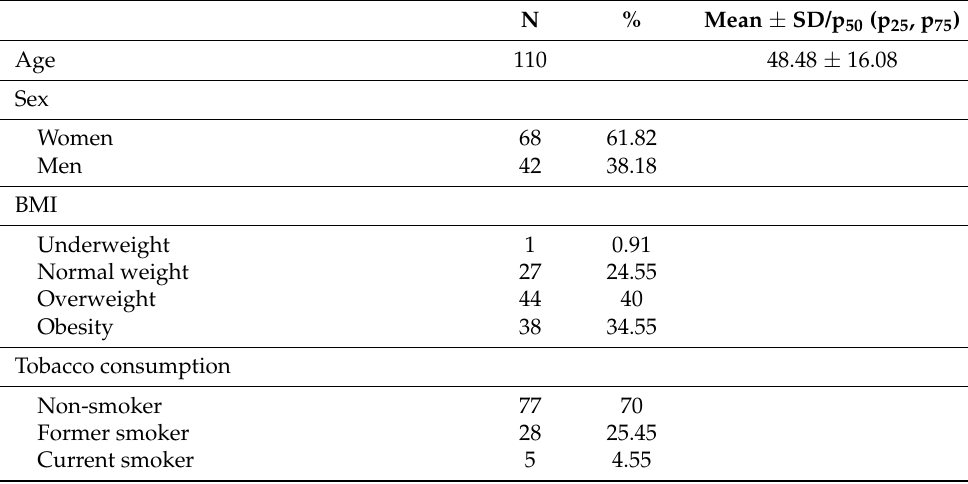
Table 1. Demographic and clinical characteristics of patients treated with